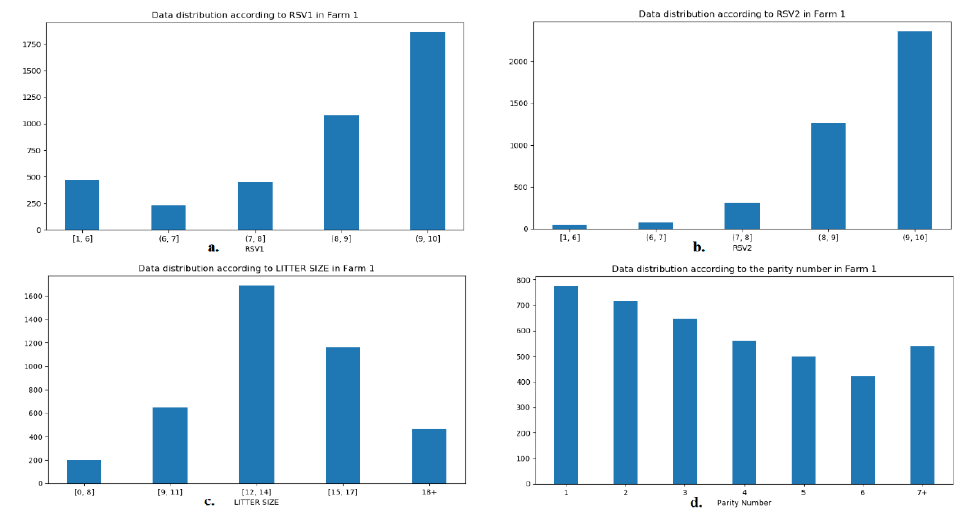
Figure 1. Distribution of the ANN data according to ( a ) RSV 1, ( b ) RSV 2, ( c ) litter size, and ( d ) parity number from Farm 1.